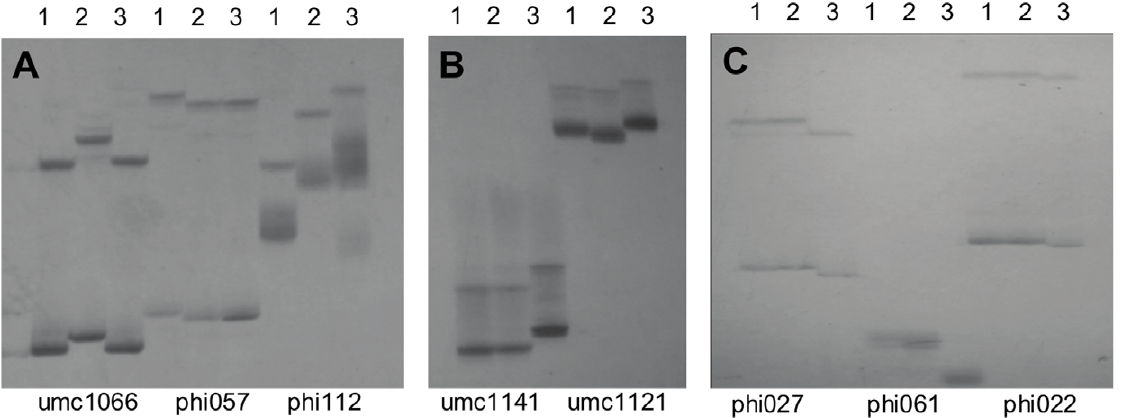
Figure 1. Electrophoresis pattern of SSR markers among three parents for target genes. (A) pattern of SSR markers within opaque-2 gene; (B) pattern of SSR markers linked to opaque-16 gene; (C) pattern of SSR markers within waxy gene; 1, Taixi19; 2, QCL3021; 3, QCL5019.